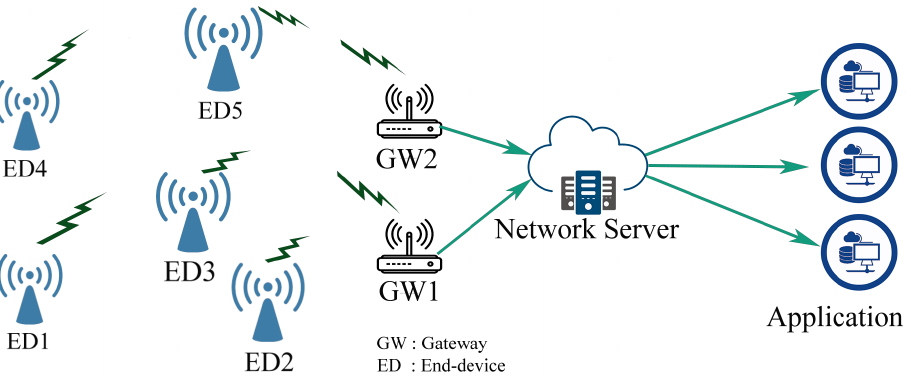
Figure 1. LoRaWAN network